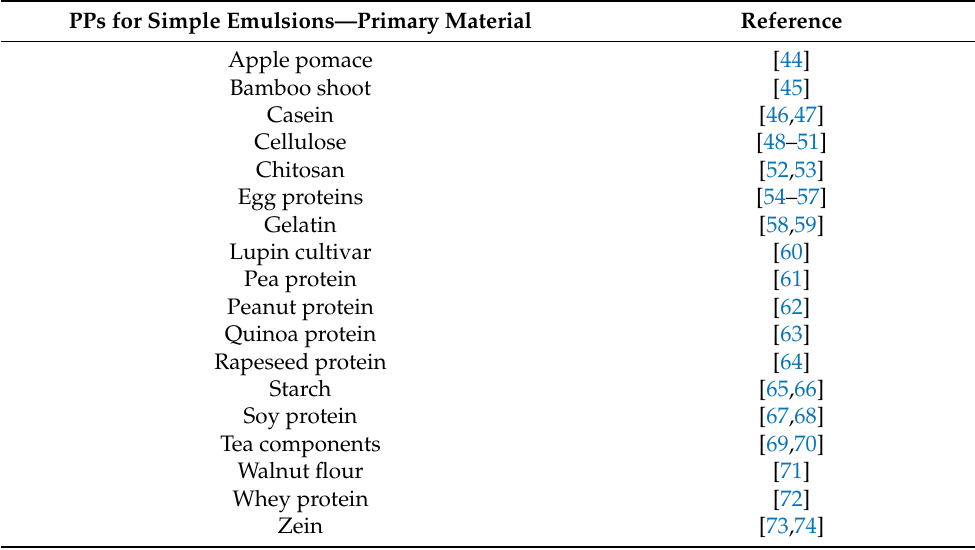
Table 1. Examples of recently published studies on food-grade PPs for preparation and stabilization of simple